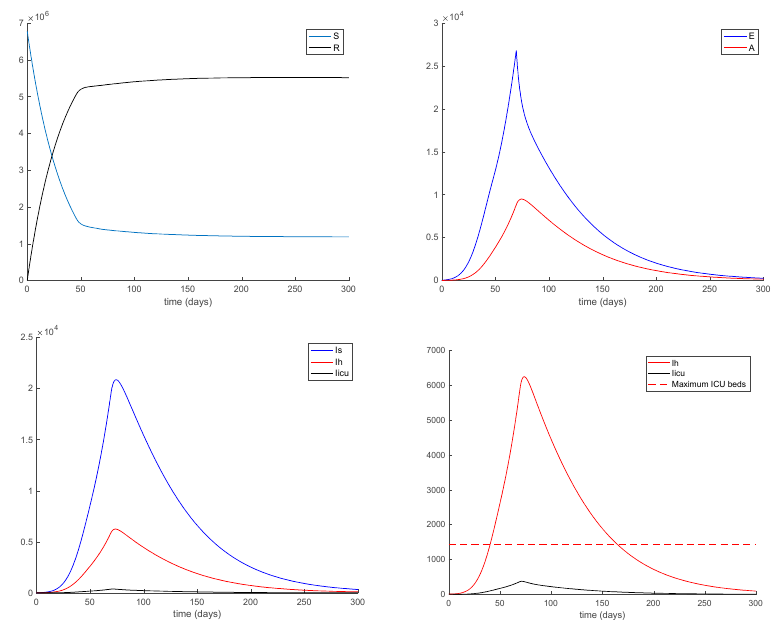
Figure 5. Evolution of all population when Programme 2 is employed and β is a control variable.